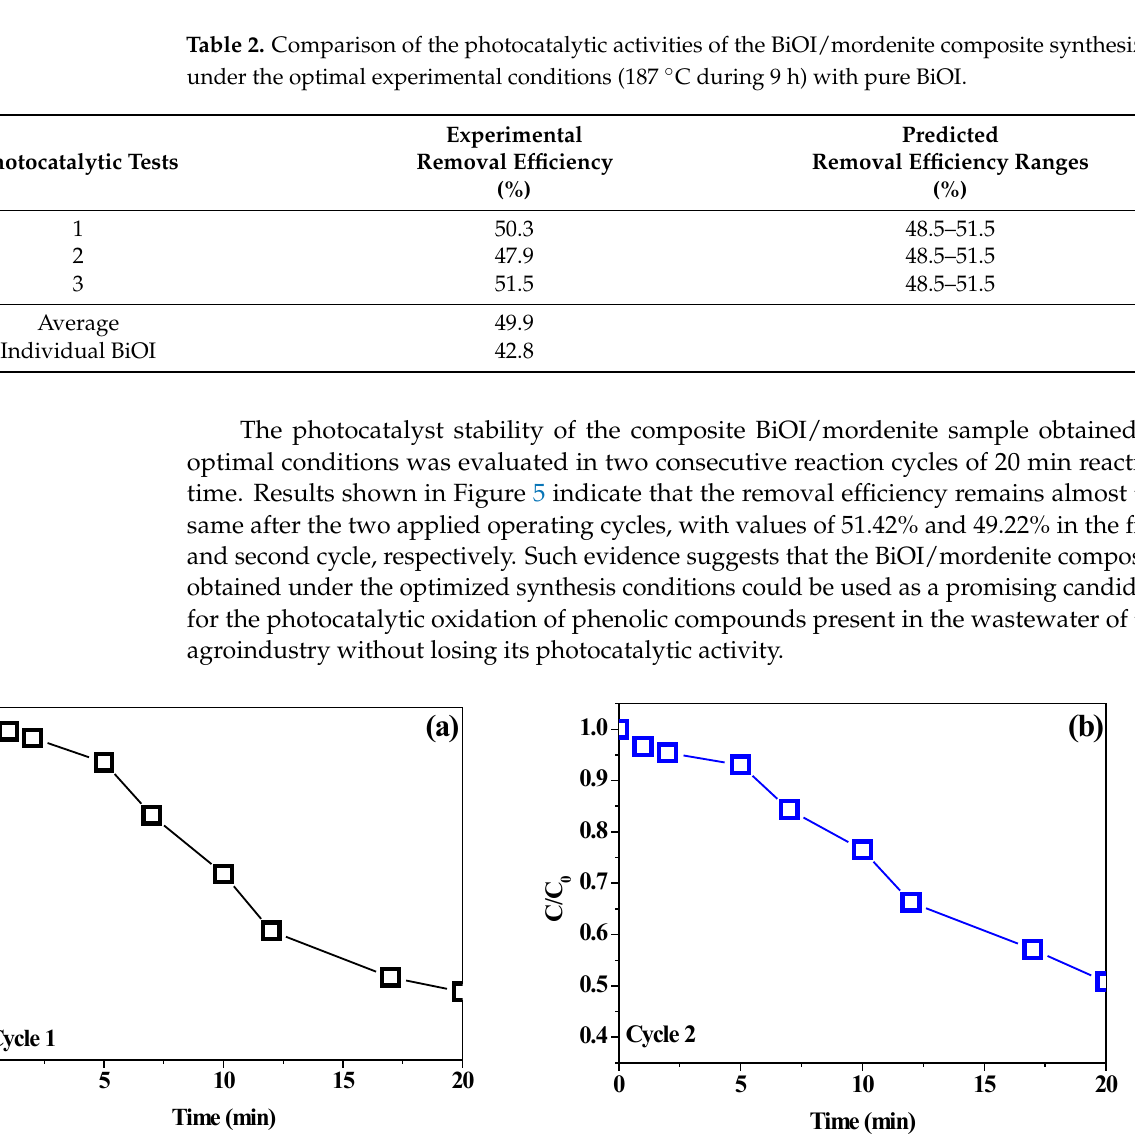
Figure 5. Stability test of optimized BiOI/mordenite composite sample after two operating cycles: ( a ) first cycle, ( b ) second cycle.